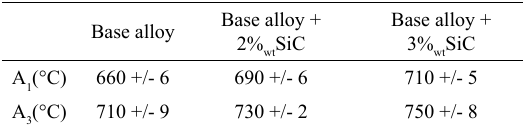
Table 4. Transformation